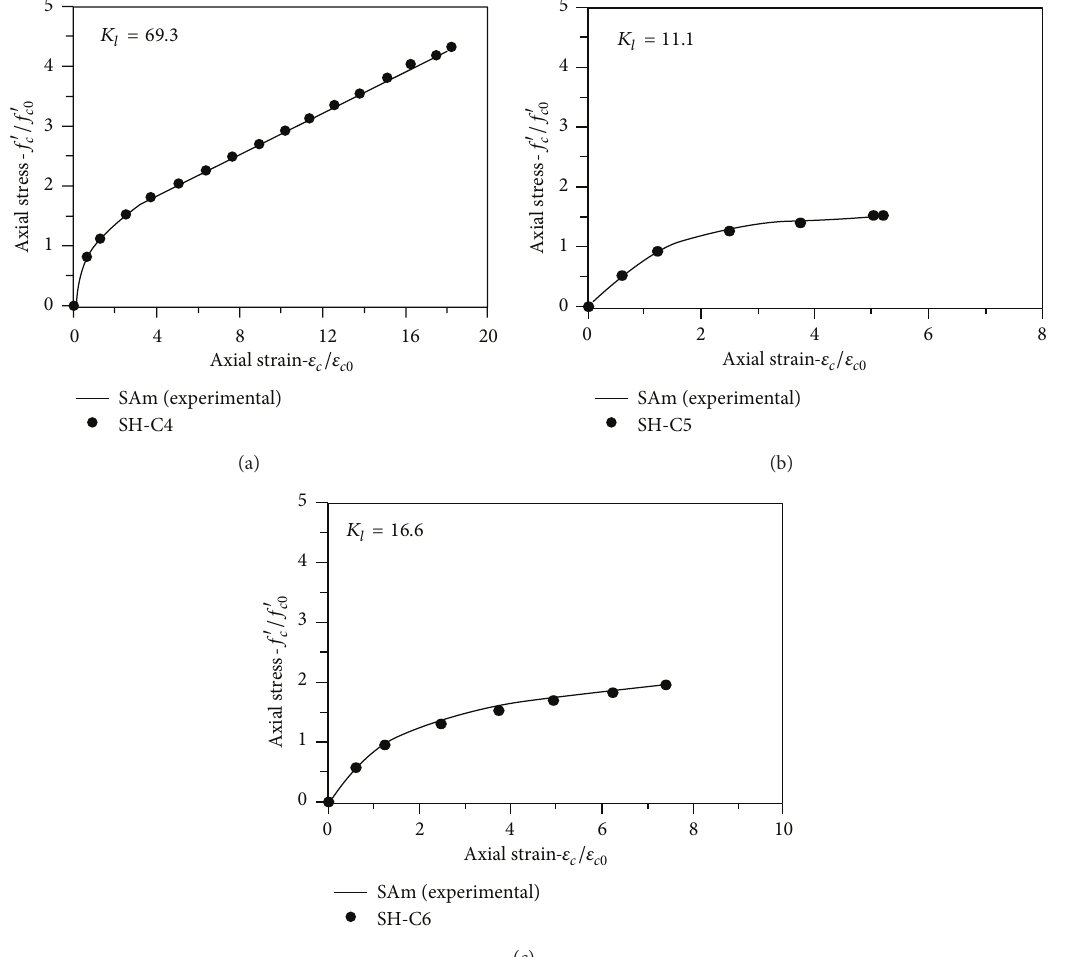
Figure 6: Stress-strain relationship: comparison of analytical results of Sargin’s modified models (SAm) with experimental